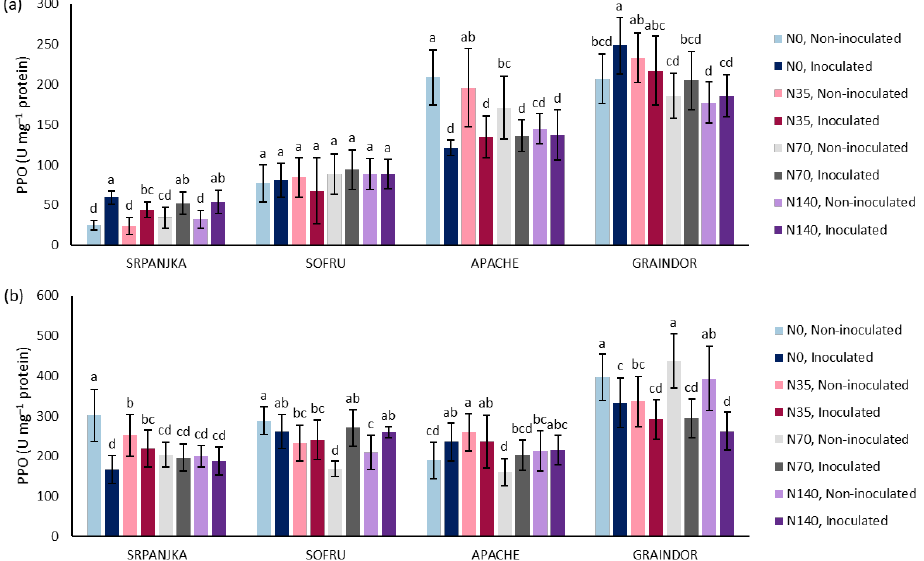
Figure 4. Polyphenol oxidase (PPO) activity in spikes of four wheat varieties under different Fusarium (non-inoculated and inoculated) and nitrogen treatments (0, 35, 70, and 140 kg N ha − 1 ) in 2018/2019 ( a ) and 2019/2020 ( b ). Values are means of eight replicates ± standard deviation (SD). Different letters above the bars indicate significant differences according to Fisher’s LSD test ( p ≤ 0.05) among treatments in each variety separately.